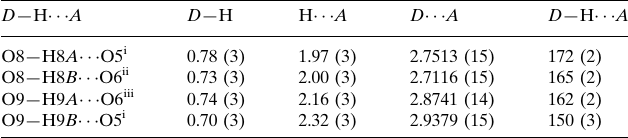
Hydrogen-bond geometry (A˚ , (cid:2)